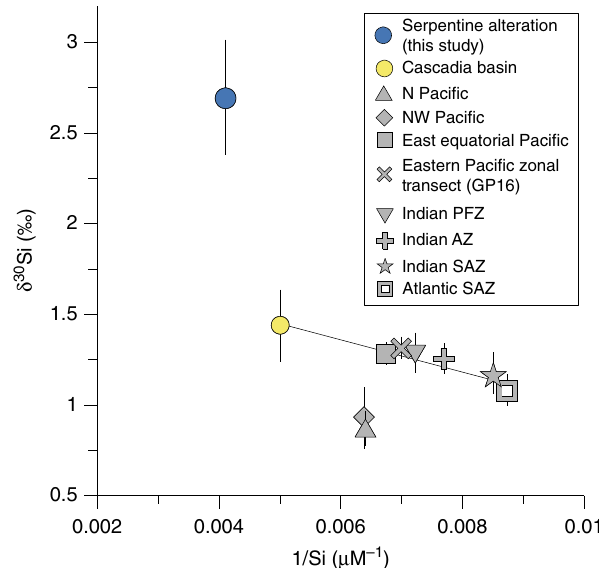
Fig. 7 Mariana seamount δ 30 Si value in the global context. Mariana seamounts median fl uid δ 30 Si value (error bar equals the coef fi cient of quartile deviation) versus the inverse Si concentration (1/Si in µ M − 1 ). In addition, Paci fi c seawater, Subantarctic Zones (SAZs), Indian Antarctic Zone (AZ), Indian Polar Frontal Zone (PFZ), and the Cascadia Basin are shown for waters below 2000 m (modi fi ed after Beucher et al. 58 , Hendry and Brzezinski 59 , and Grasse et al. 17 and references therein). Note that most seawater data fall on a single mixing line (shown in black), between waters of the Cascadia Basin and the SAZs. High Si concentrations and δ 30 Si values in the Cascadia Basin might result from serpentine alteration (see text for